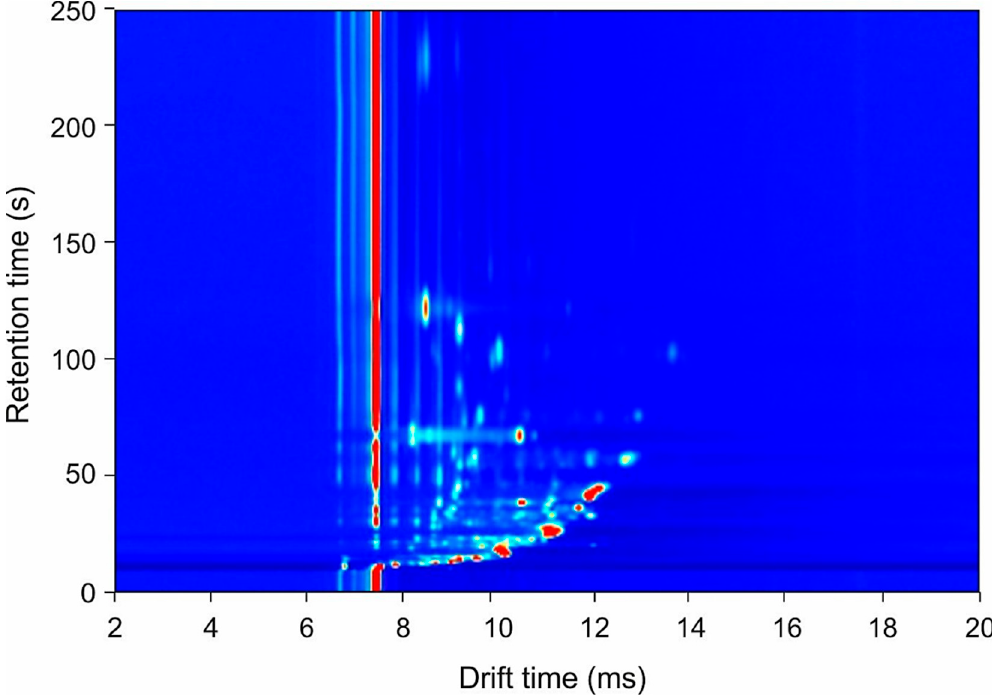
Figure 1. An example output of the gas chromatography–ion mobility spectrometry (GC-IMS) instrument. Depicted is an example output of the GC-IMS (FlavourSpec ® , G.A.S., Dortmund, Germany) using a refractory coeliac disease sample. The y -axis represents retention time from the gas chromatography column, and the x -axis represents drift time through the ion mobility spectrometer. Levels of volatile organic compounds in the sample are represented by colour intensity.